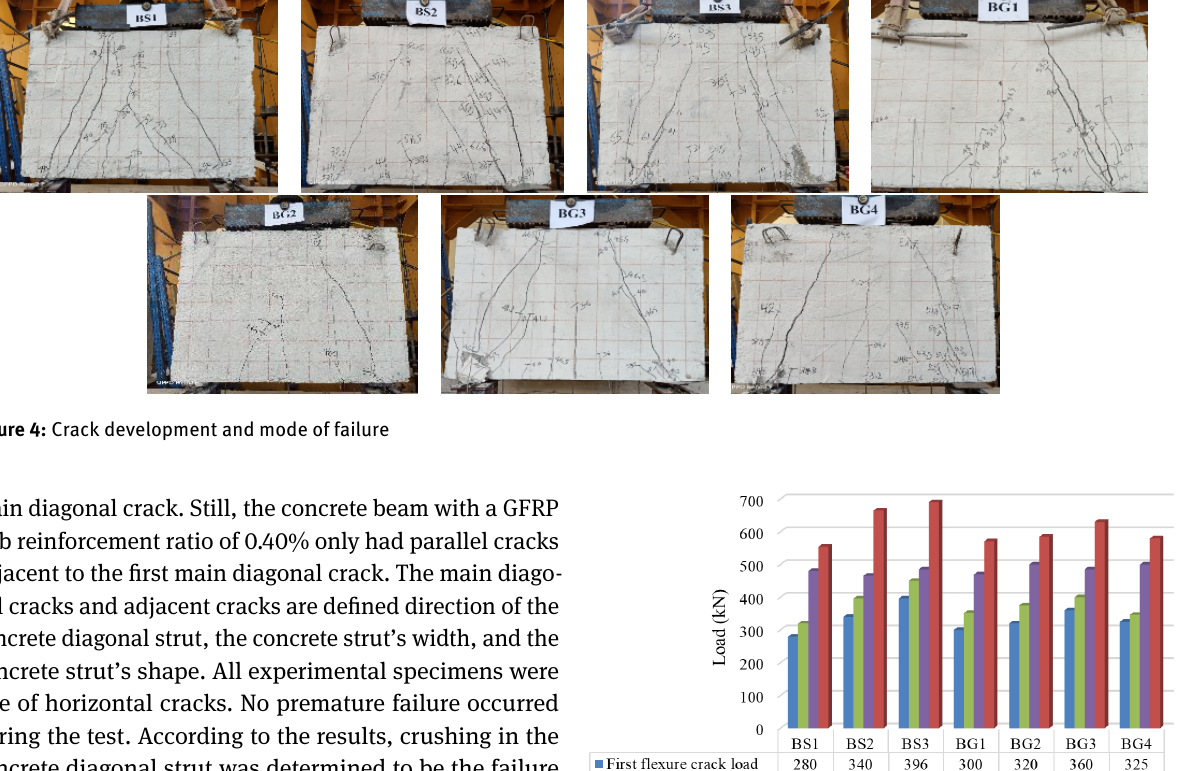
was later than the first shear crack for other